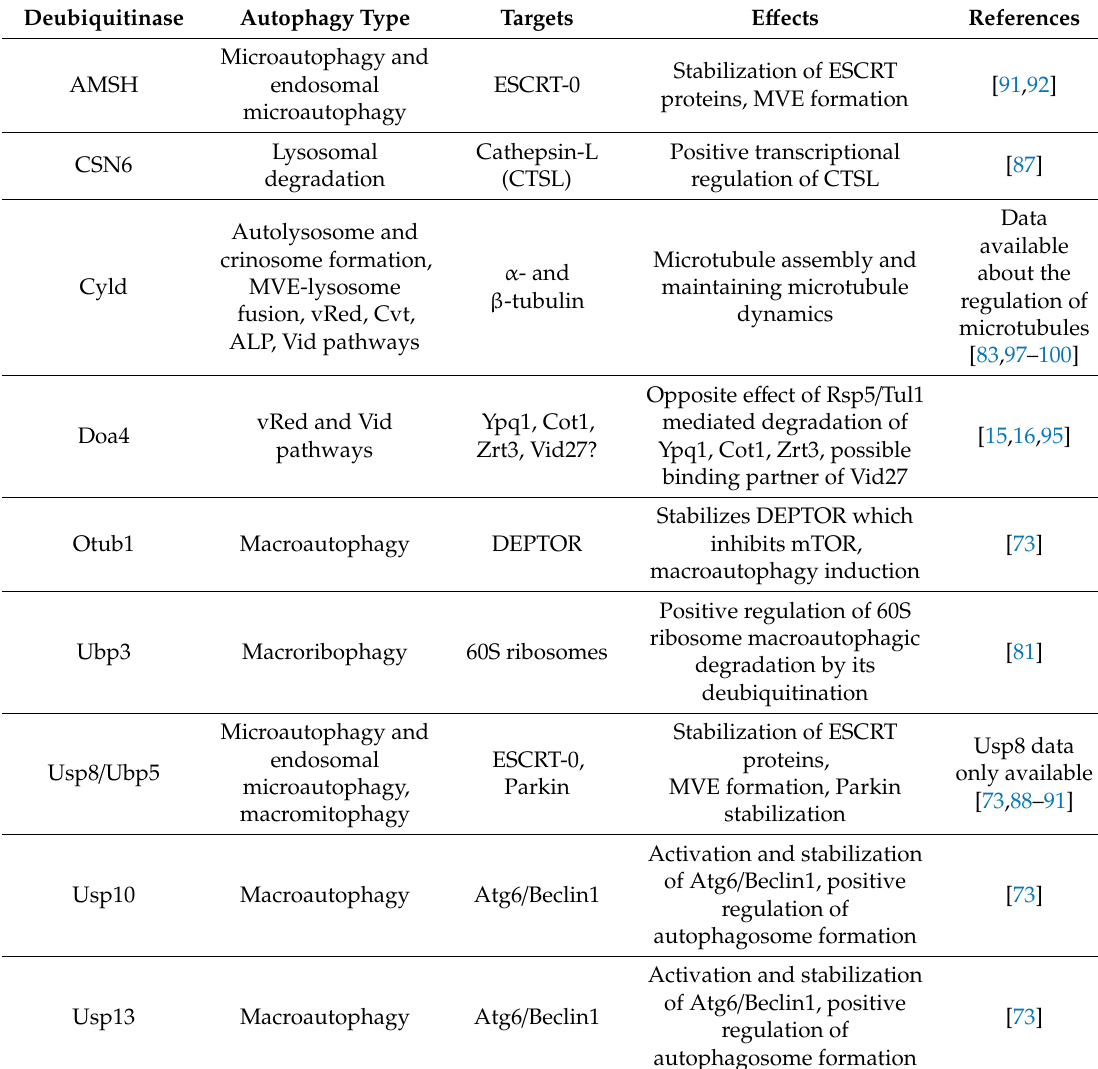
Table 1. Summary of the relevant deubiquitinases and their e ff ects in several autophagic processes.